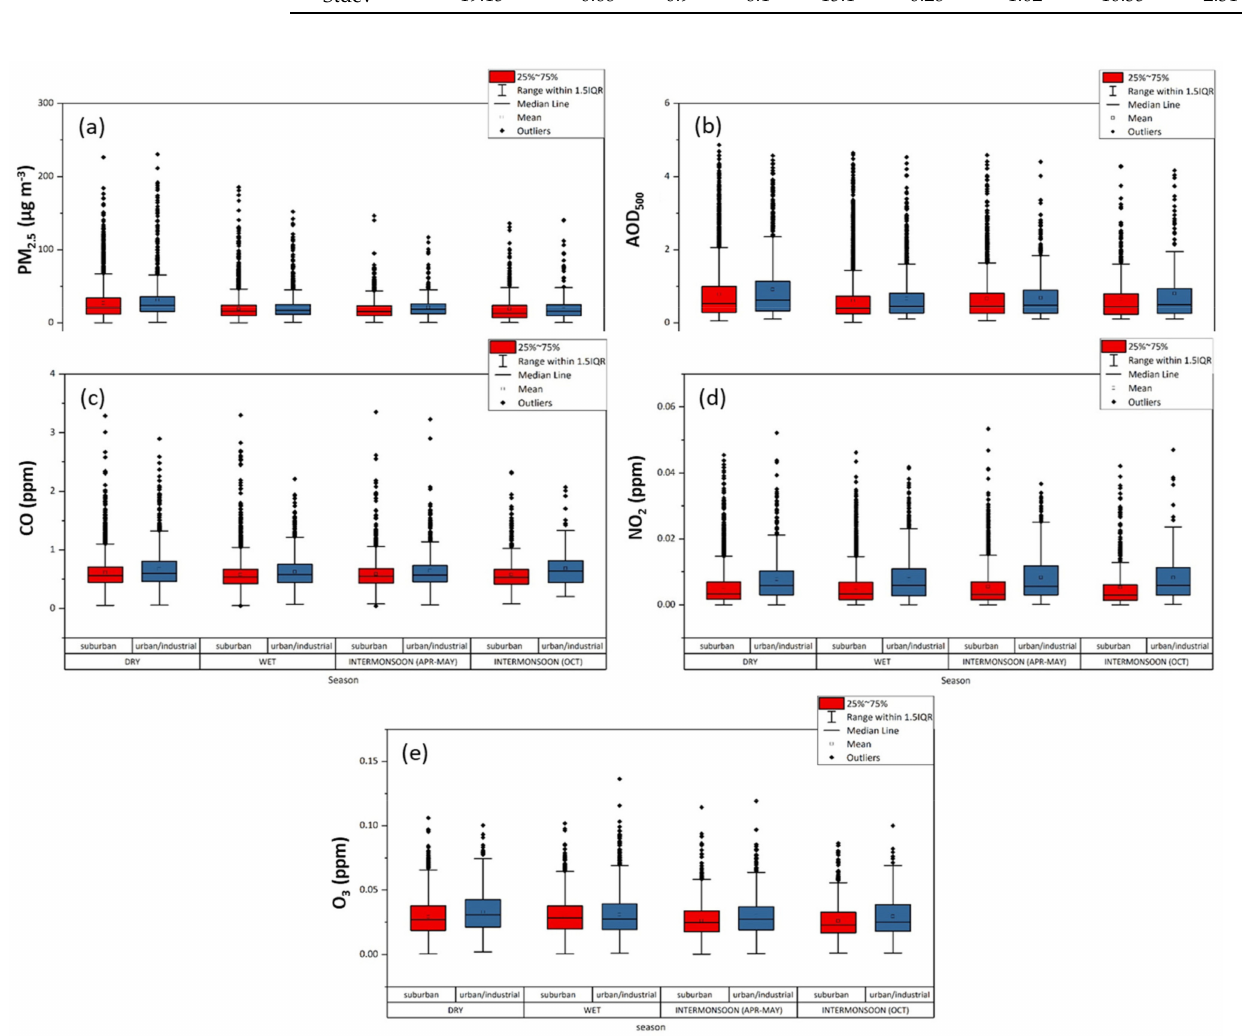
Figure 3. Box plots of measured PM 2.5 concentrations ( a ) Himawari-8 AOD 500 ( b ), CO ( c ), NO 2 ( d ) and O 3 ( e ) at ur- ban/industrial and suburban/rural sites in Malaysia in the dry, wet and inter-monsoon seasons. The box-whisker plots for AOD 500 and air pollutants, separated for urban/industrial and suburban/rural sites and for the four seasons, are shown in Figure 3. The analy-